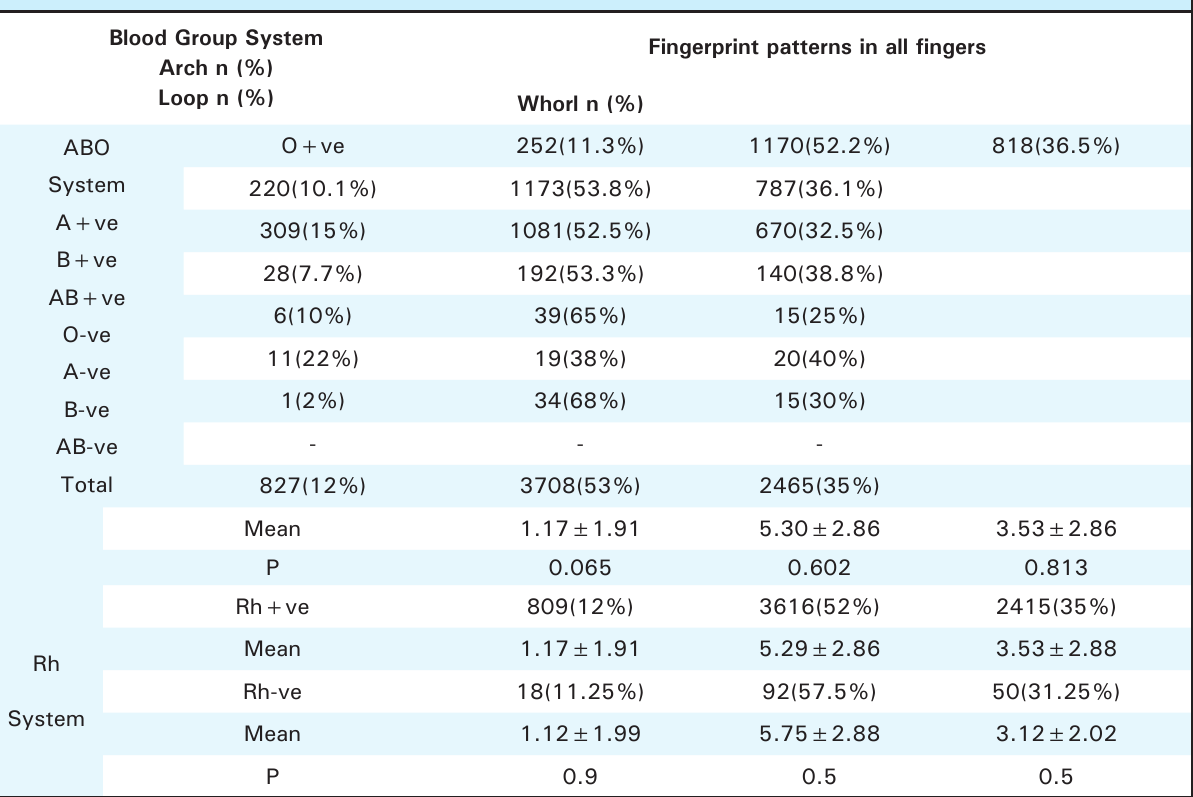
The maximum number of loops was seen in left small (S) finger of O+ve blood group. However, the percentagewise loop distribution was highest in right middle fingers of B-ve blood group. There was